Question: State the chart type depicted above.
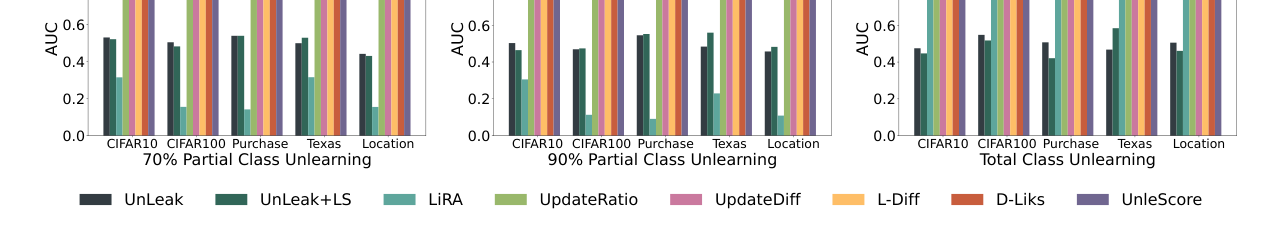
Answer: line